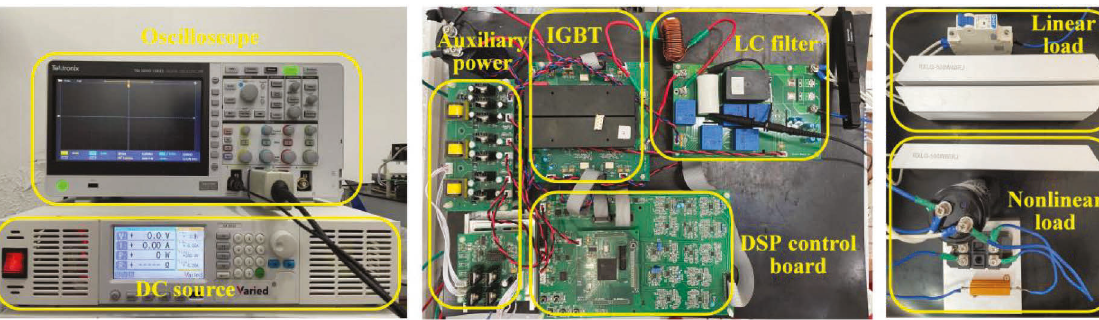
Figure 17: Experimental